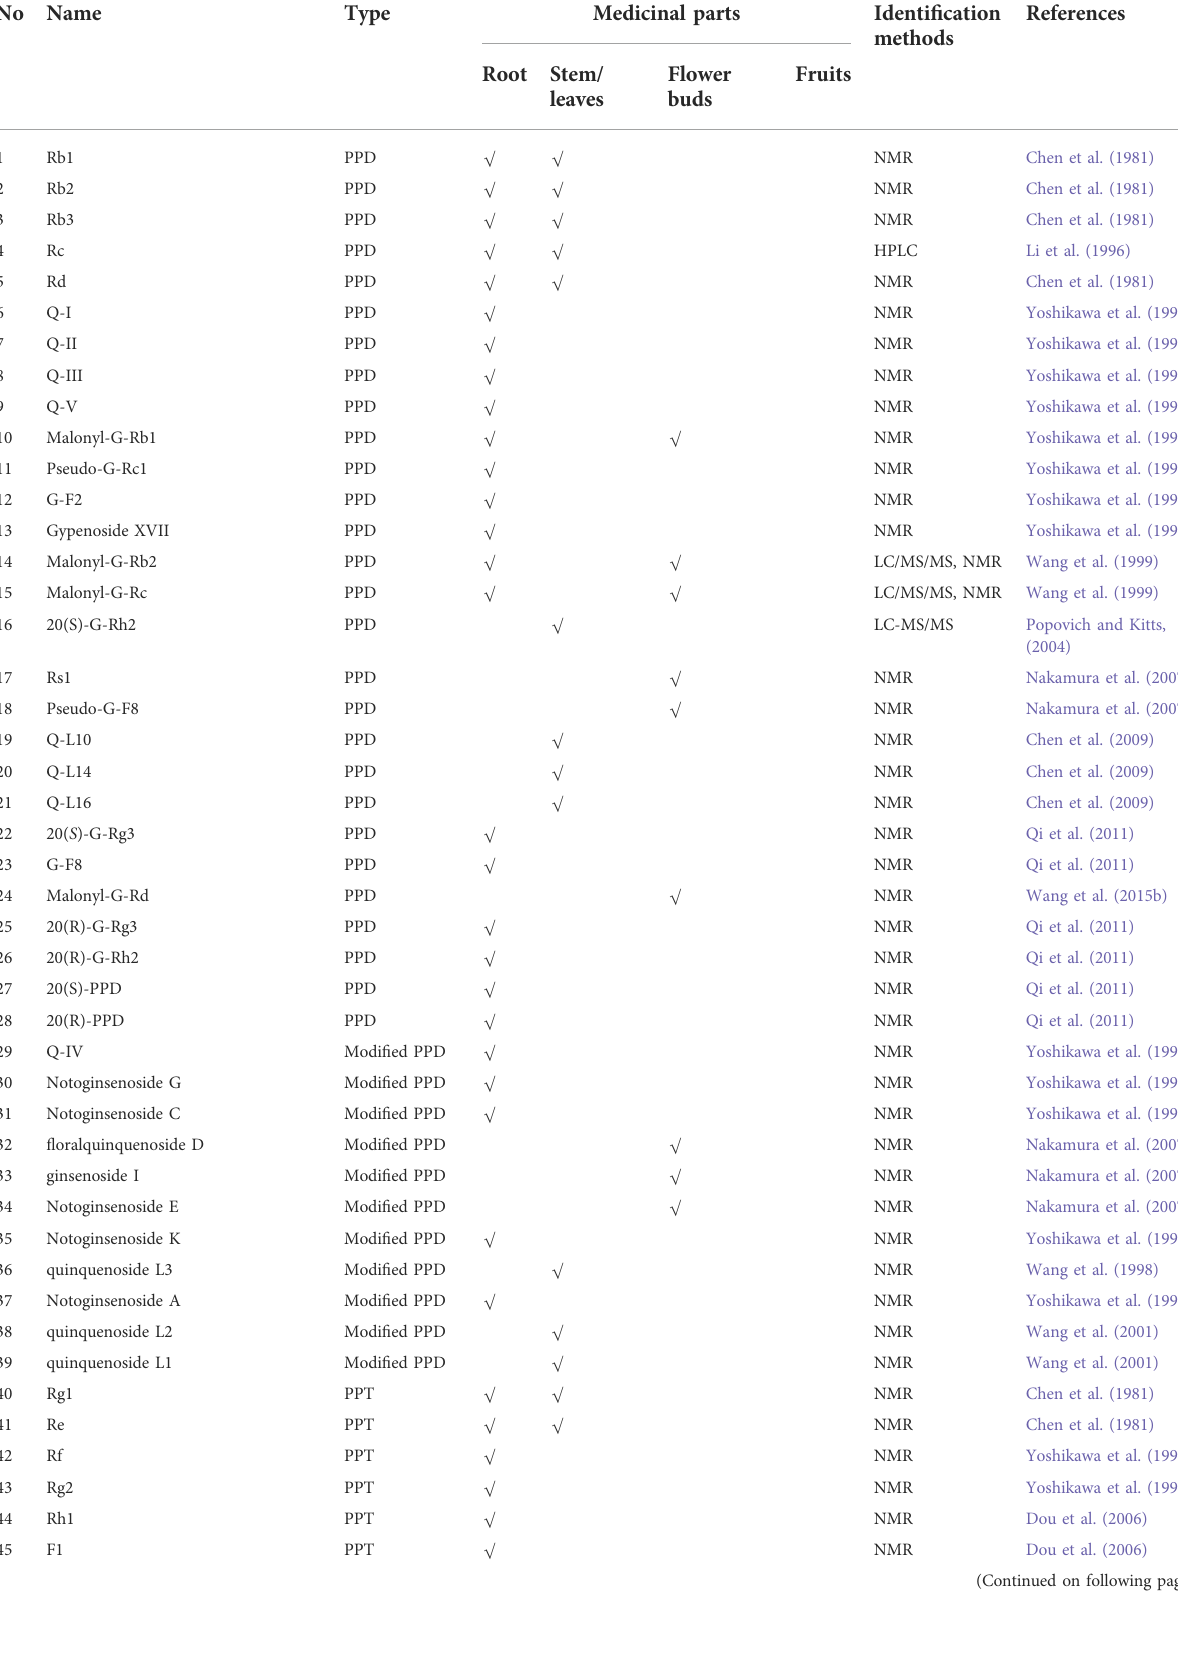
TABLE 1 The natural occurring ginsenosides in different parts of P. quinquefolius